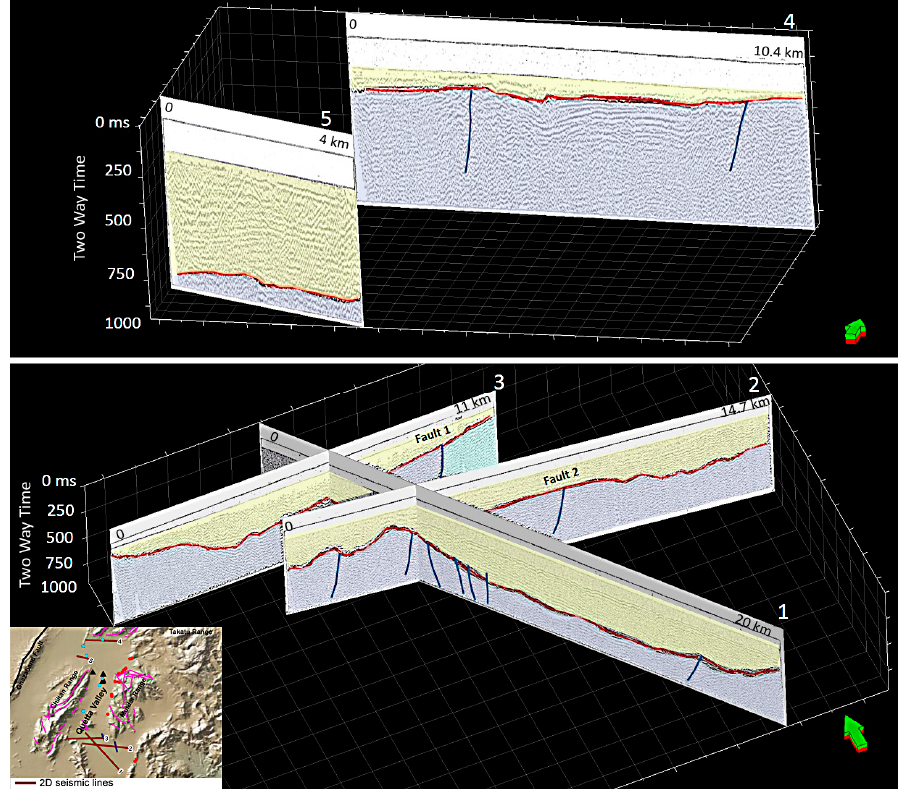
Figure 5. ( Top ) Seismic profile 4 and 5 show the top of Shrinab Limestone (red horizons) and two thrust faults, shown on profile 4, dipping westward. ( Bottom ) Seismic profile 1, 2 and 3 show the top of Shrinab Limestone (red horizons) and many blind thrust faults. Only one thrust fault mapped on profile 3 serves as a boundary between the Shrinab and Chiltan Formations.